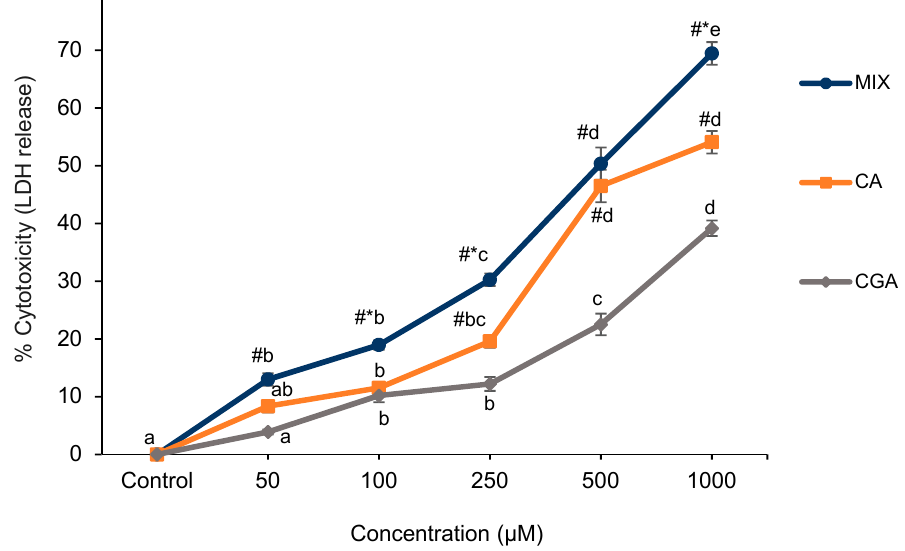
Figure 3. Effect of treatment with different doses of CGA, CA and MIX for 24 h on Caco-2 cell cytotoxicity as evaluated by the LDH assay. Data are represented as mean ± SE. Statistical analysis was performed via two-way ANOVA using treatment and dose as factors. Doses within the same treatment not sharing common letters are significantly different ( p < 0.05). The symbol # represents a significant difference ( p < 0.05) between CGA and either of the two other treatments at a specific dose. The symbol * represents a significant difference ( p < 0.05) between MIX and CA at a specific dose. CGA = chlorogenic acid; CA = caffeic acid; MIX = equimolar mixture of the four tested compounds; LDH = lactate dehydrogenase.